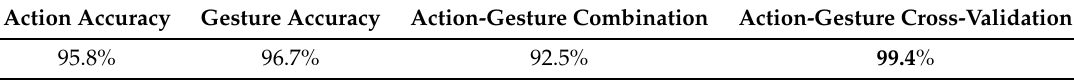
Table 9. The recognition accuracy of each module in our system when Recall Rate is 0.98.(trained and tested by our datasets, accuracy just refer to the recalll rate of Equation (7)). Action Accuracy